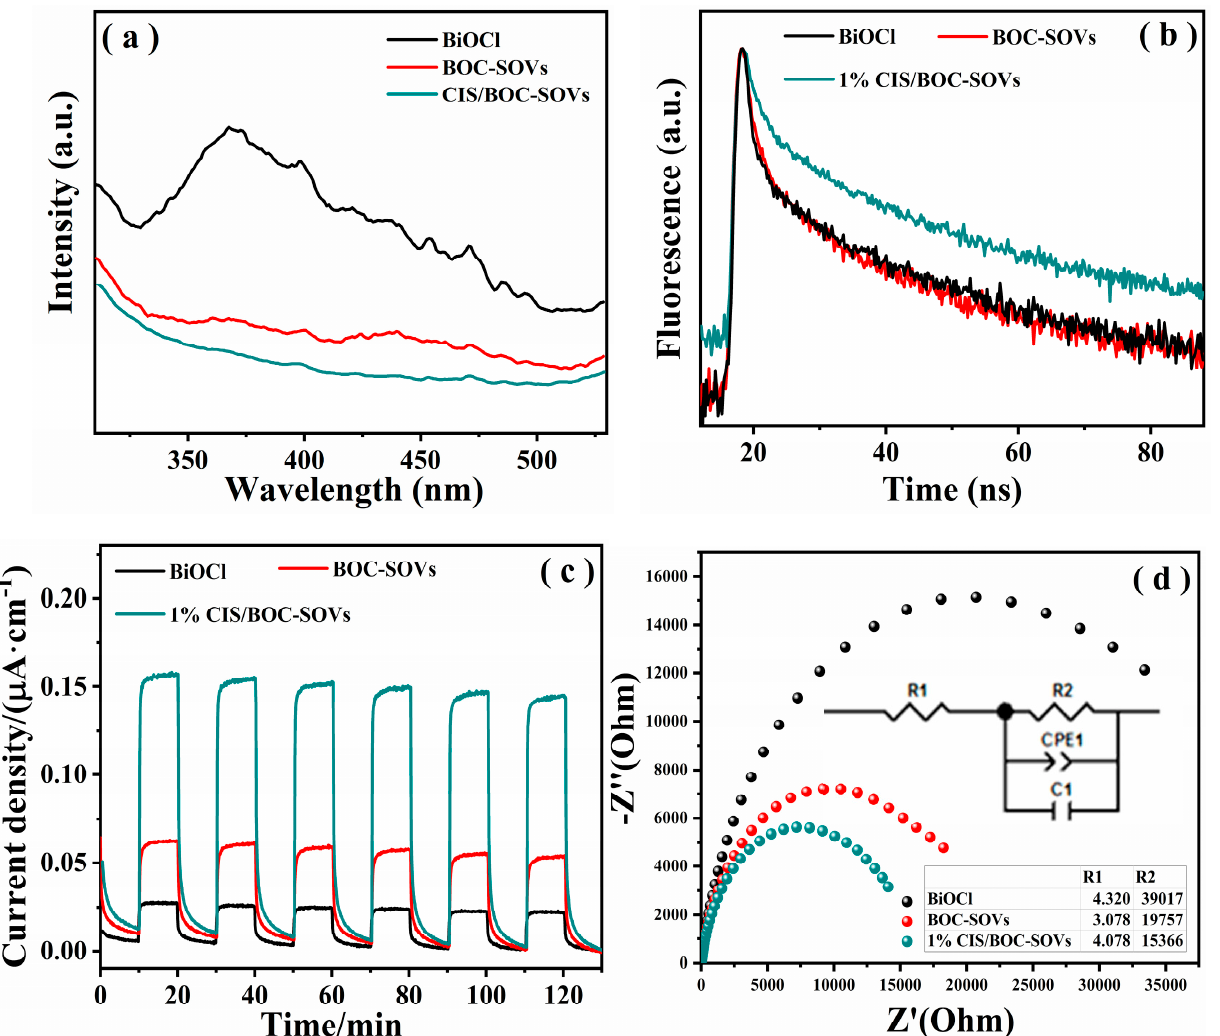
Figure 10. ( a ) Photoluminescence spectra, ( b ) Time-resolved fluorescence decay spectra, ( c ) Transient photocurrent response, and ( d ) Electrochemical impedance spectroscopy of BiOCl, BOC-SOVs, and 1% CIS/BOC-SOVs.